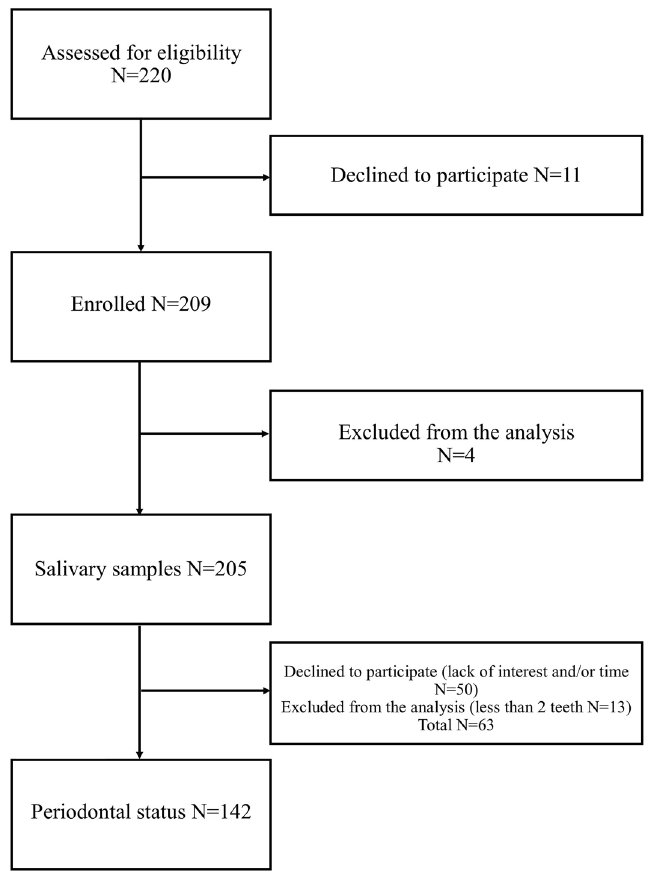
Figure 1. Flow diagram of the study subject enrolment